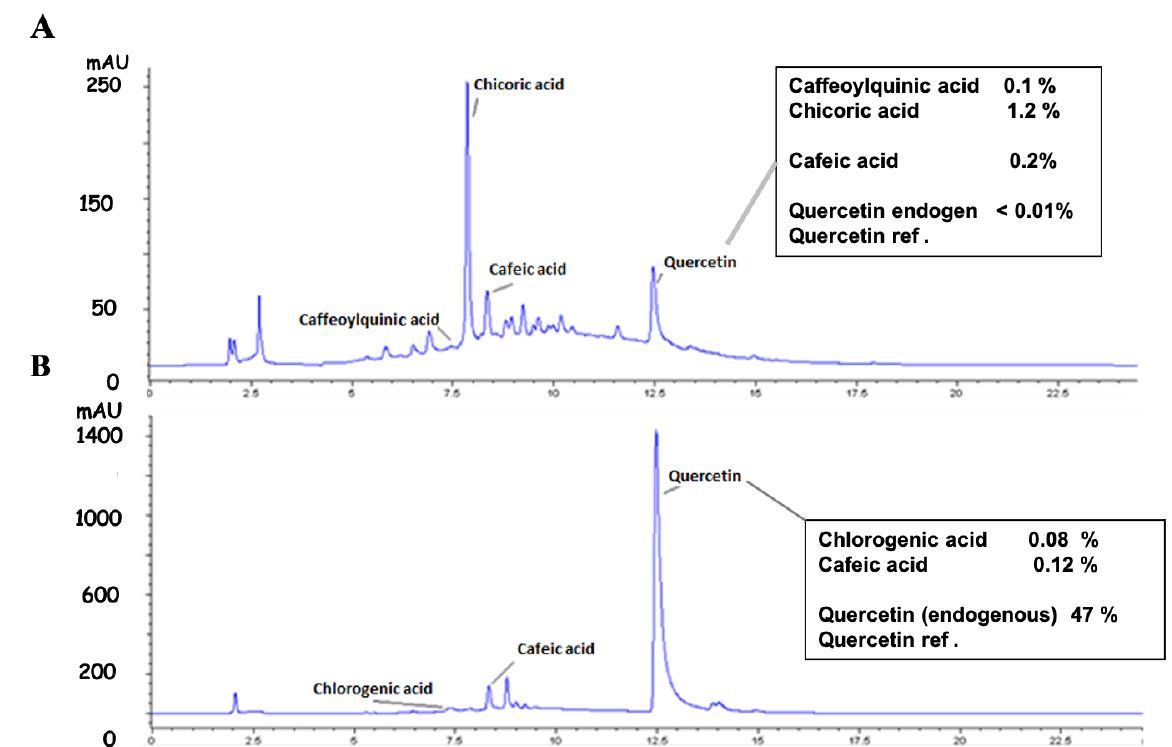
Figure 2. Quantification of caffeoyl derivatives in Oc and Mu leaves extracts by HPLC. ( A ) chromatogram obtained with Ocimum gratissimum L. extract (Oc). ( B ) chromatogram obtained with Musanga cecropoides R. Br. ex Tedlie (Mu). A standard solution containing chlorogenic acid, caffeic acid, and chicoric acid at 10 µM each were used as peak area references. A 5 µM external quercetin marker was subsequently added to Oc and Mu extracts to normalize the data analysis. The high uptick found in Mu represents both quercetin (the endogene part and the reference added) and probably the apigenin contents in Mu extract.